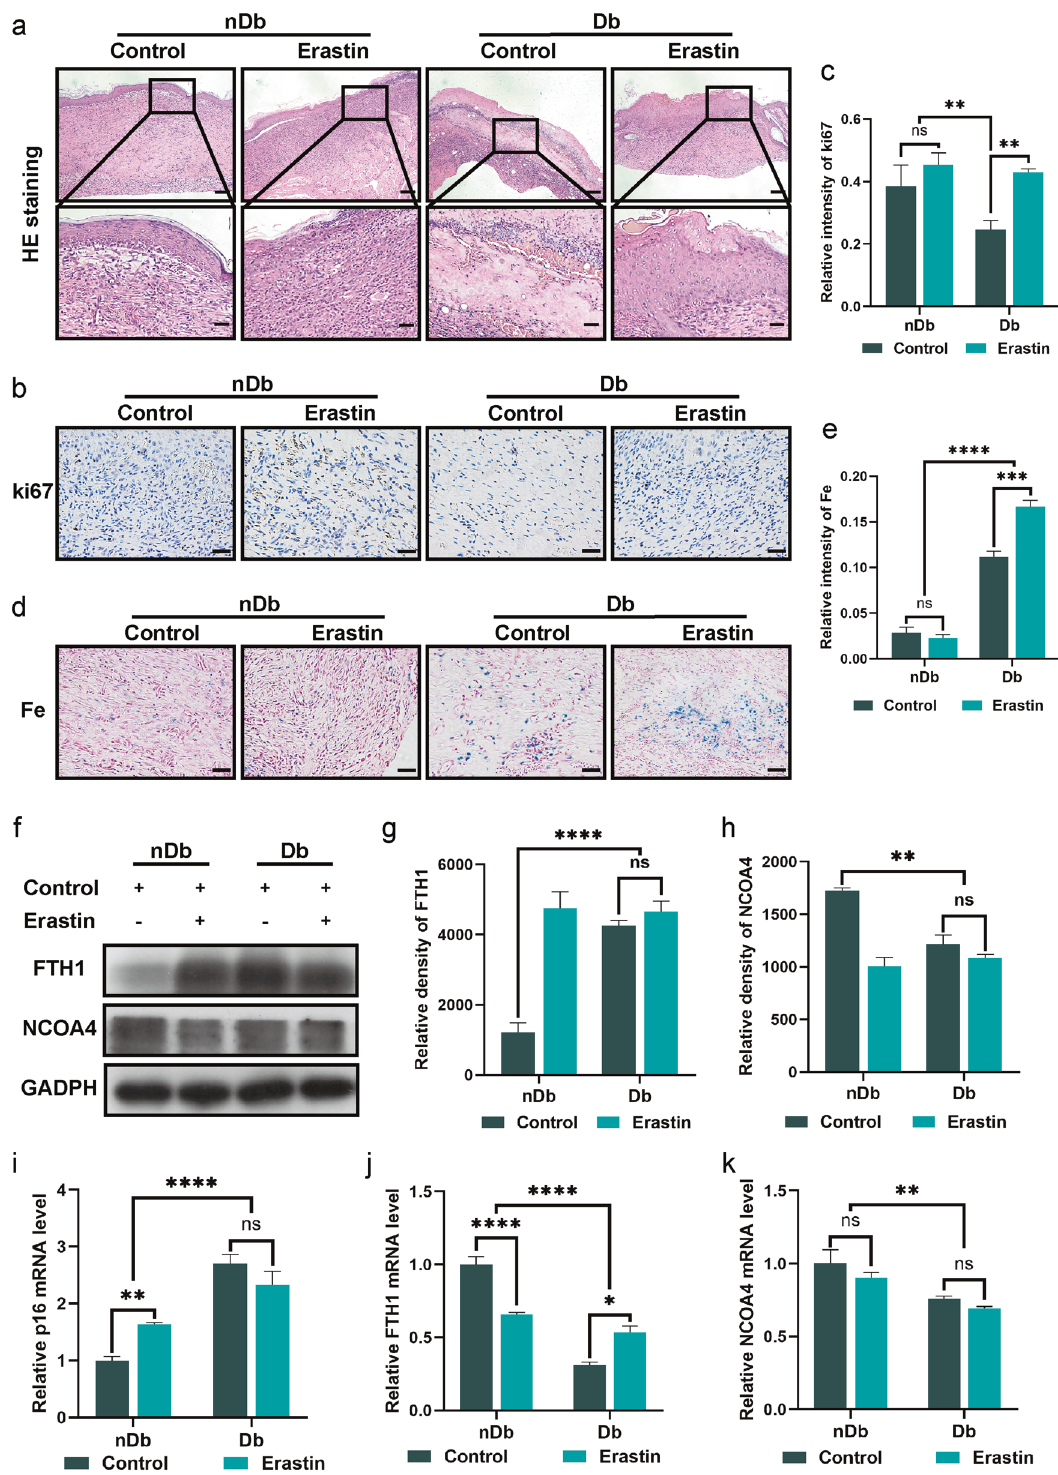
Fig. 6 Erastin accelerate wounds healing process. a H&E staining of the wound indicated the healing situation on day 14. Scale bar = 200 μ m (upper). b Immunohistochemistry staining of Ki67 in nDb and Db wound sections at day 14 after surgery. Scale bar = 50 μ m. c Quantitative evaluation of the Ki67-positive cell ratio. d Prussian blue staining of the nDb and Db wounds at day 14 after surgery. Scale bar = 50 μ m. e Quantitative evaluation of the Prussian blue-positive cell ratio. f Immunoblot of FTH1 and NCOA4 in wounds with the indicated treatment. g , h Quanti fi cation of FTH1 and NCOA4 immunoblotting in f . i , j The mRNA level of p16, FTH1, and NCOA4 were detected by real-time PCR in wounds with the indicated treatment. Data represent the mean ± SEM of triplicates. ** P < 0.01; *** P < 0.001; **** P < 0.0001; ns nonsigni fi cant, nDb non-diabetic, Db diabetic.